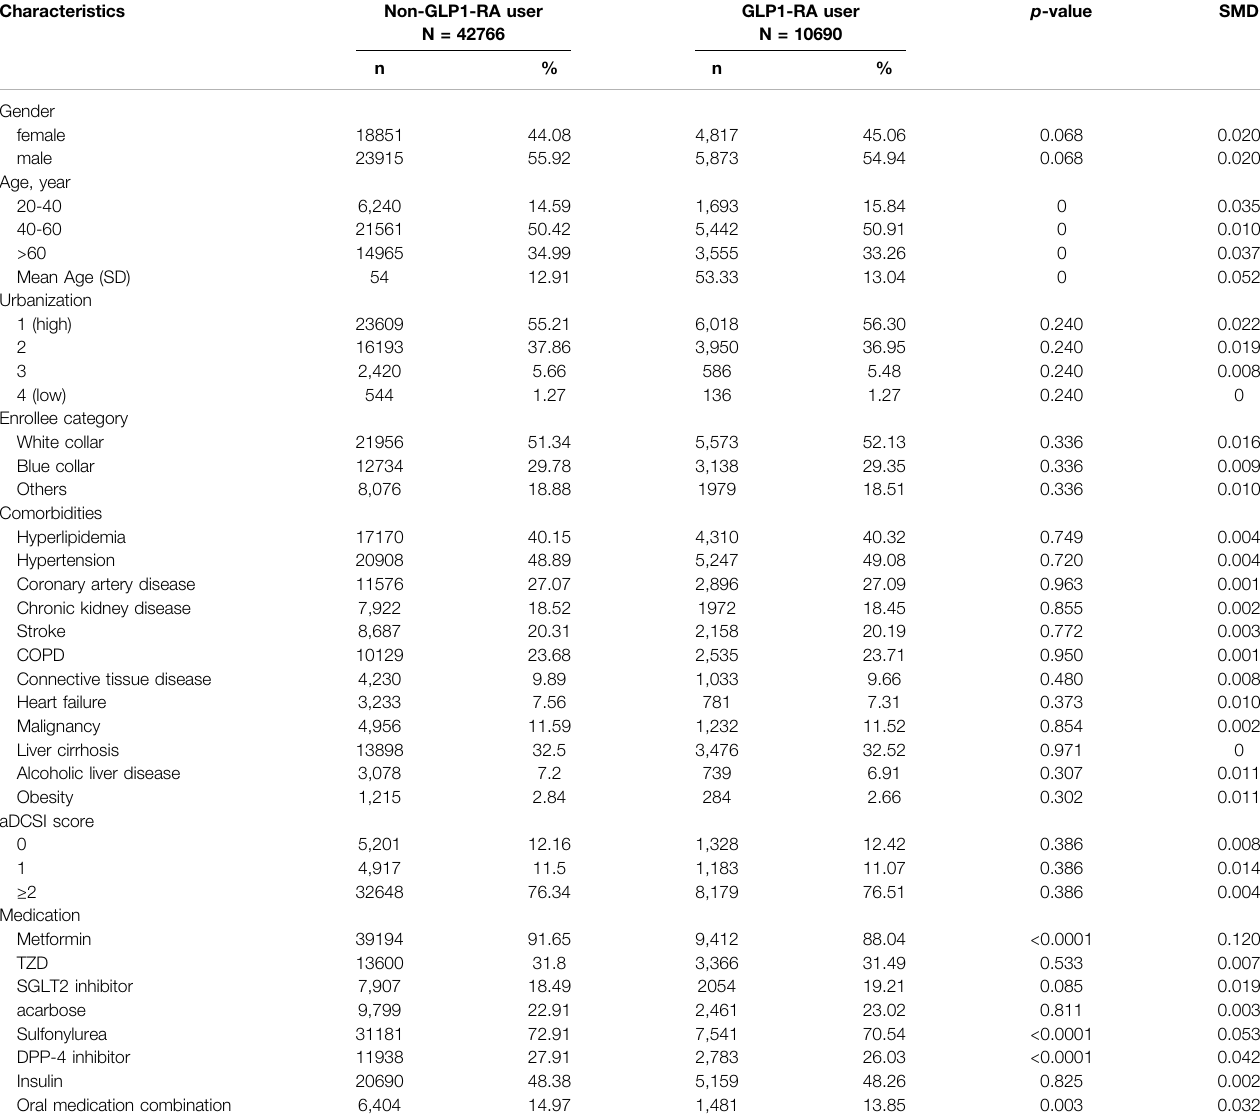
TABLE 1 | Baseline demographic factors and comorbidities of study population according to GLP1-RA use. Characteristics